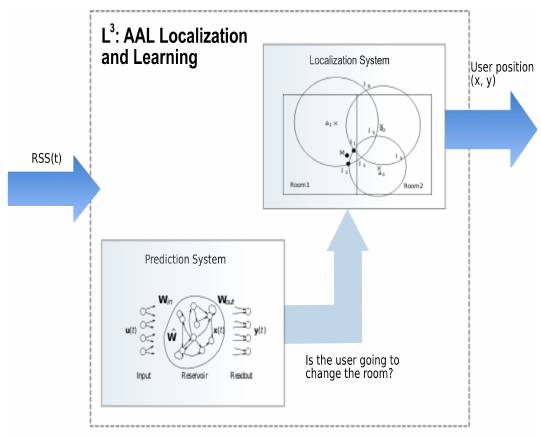
Figure 1. The L 3 system: The same received signal strength (RSS) data stream is used both by the Prediction and the Localization subsystems. The output of the Prediction subsystem is the input to the Localization